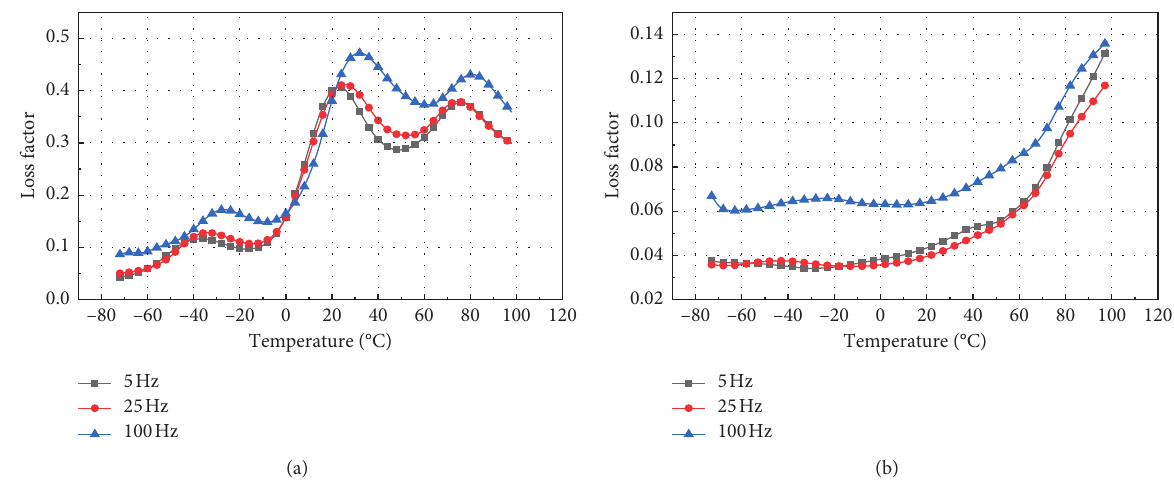
Figure 6: Loss factor spectrum at different frequencies. (a) D-803-Z. (b) PU foam (175kg/m 3